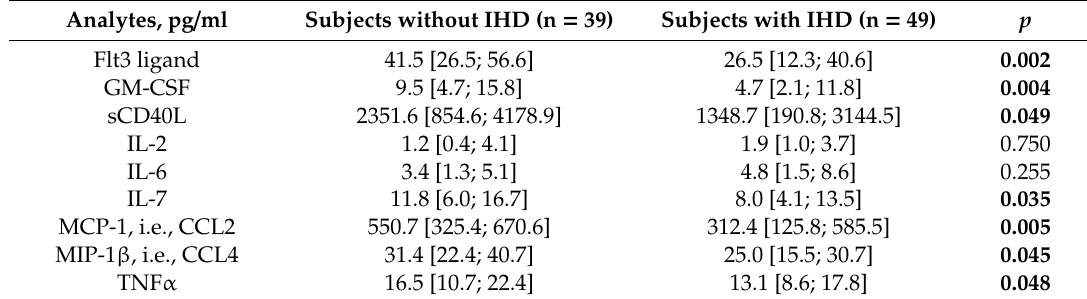
Table4. Levelsofthehumancytokines / chemokinesinIHD(median[lower; upperquartile]), ELISAdata. Analytes, pg / ml